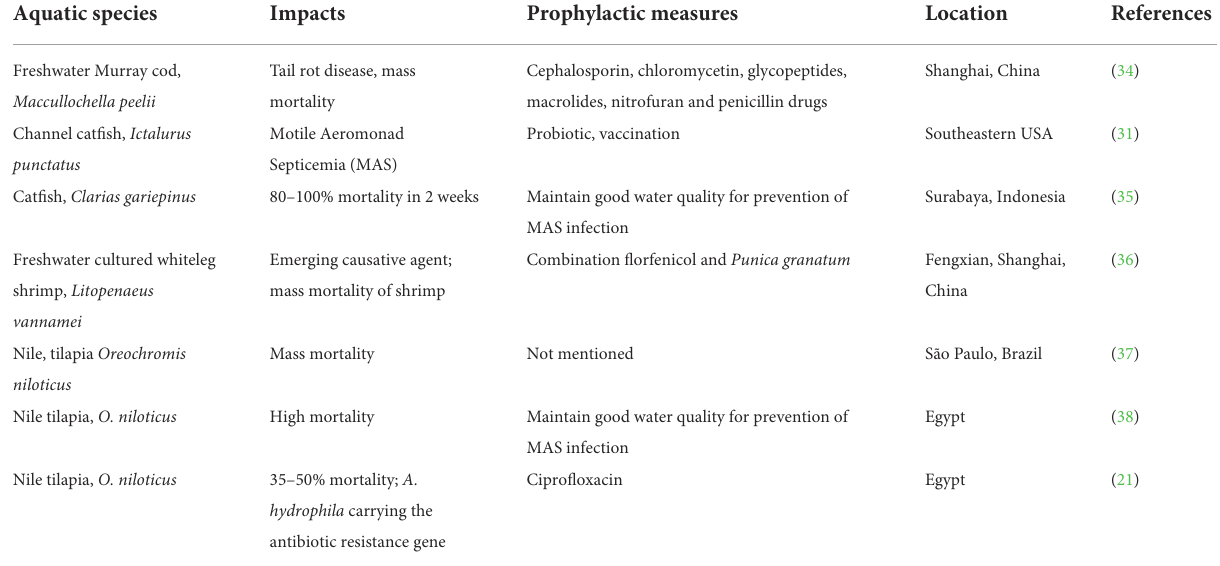
TABLE 1 Impacts of MAS in